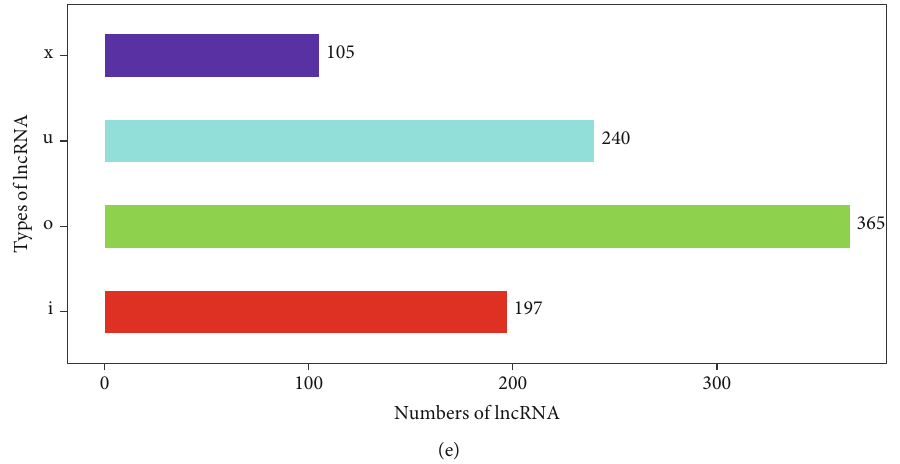
Figure 5: Di ff erential expression pro fi les of mRNA-lncRNAs between undi ff erentiated and di ff erentiated MSCs. (a) The volcano fi gure of the di ff erentially expressed mRNAs between 5-AZA-treated and untreated cells, respectively (C3h10_1 and C3h10_2: control; C3h10_101 and C3h10_102: case). (b) Di ff erential gene expression pro fi ling was identi fi ed by hierarchical clustering analysis, indicating that undi ff erentiated and di ff erentiated stem cells exhibited dramatically di ff erentially expressed gene pro fi le (C3h10_1 and C3h10_2: control; C3h10_101 and C3h10_102: case). (c) The volcano fi gure of the di ff erentially expressed lncRNAs between 5-AZA-treated and untreated cells, respectively (C3h10_1 and C3h10_2: control; C3h10_101 and C3h10_102: case). (d) Di ff erential lncRNA pro fi ling was identi fi ed by hierarchical clustering analysis, indicating that undi ff erentiated and di ff erentiated stem cells exhibited a dramatically lncRNA expression pro fi le (C3h10_1 and C3h10_2: control; C3h10_101 and C3h10_102: case). (e) Statistics of lncRNA types showed that there are (i) 240 intergenic lncRNAs (u), (ii) 197 intronic lncRNAs (i), (iii) 105 anti-sense lncRNAs (x), (iv) 365 sense-overlapping lncRNA intergenic